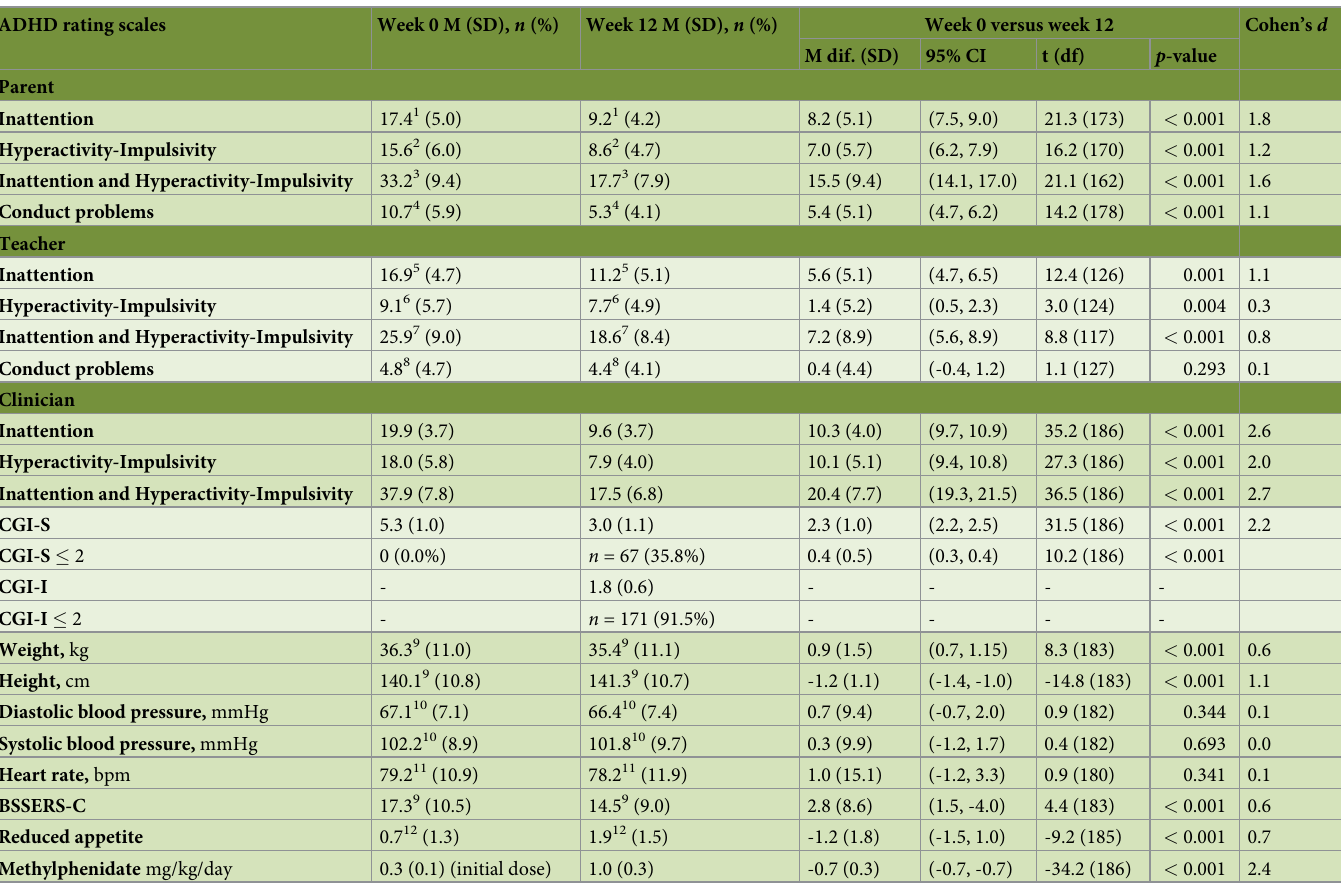
Table 2. Clinical follow-up from week 0 to week 12 ( n =